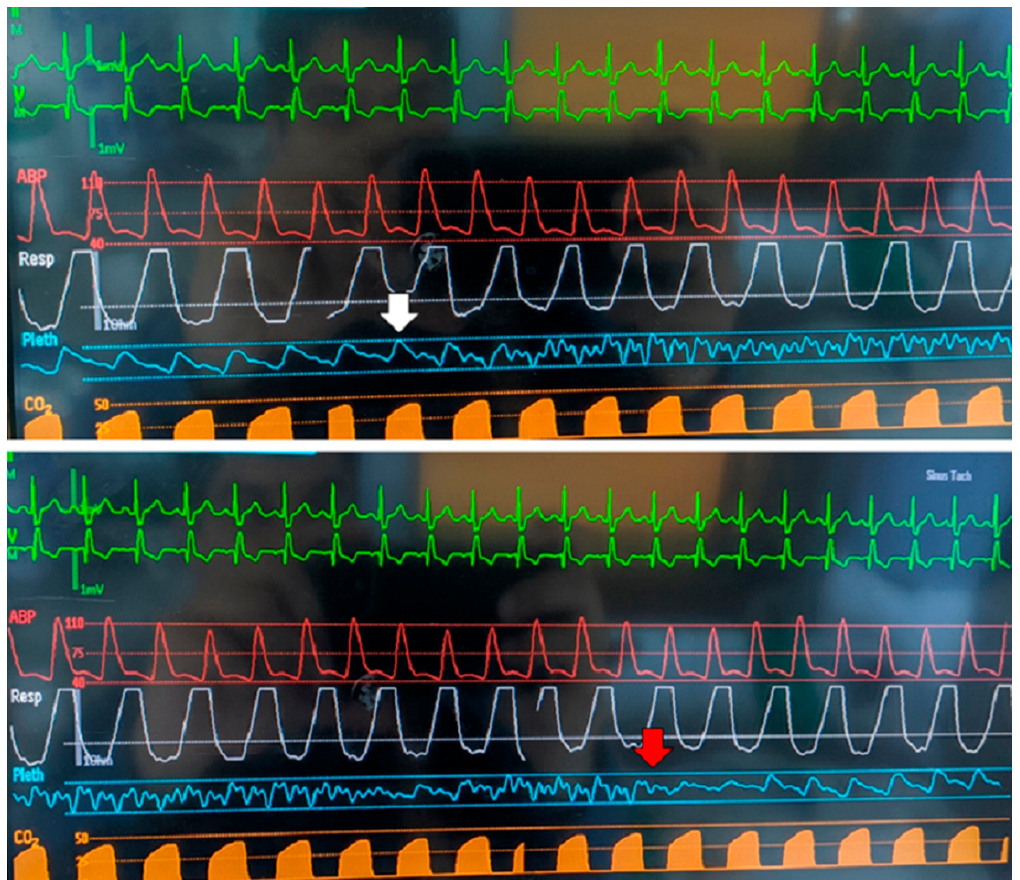
e ff ect that the navigated transcranial magnetic stimulation (nTMS) navigational system imposes on pulse oximetry. The underlying mechanism is likely the infrared-spectrum based navigational camera creating interference with light used in pulse oximetry. The white arrow indicates the moment at which the camera was positioned for nTMS navigation. The red arrow indicates the moment at which a layer of textiles was put over the pulse oximetry